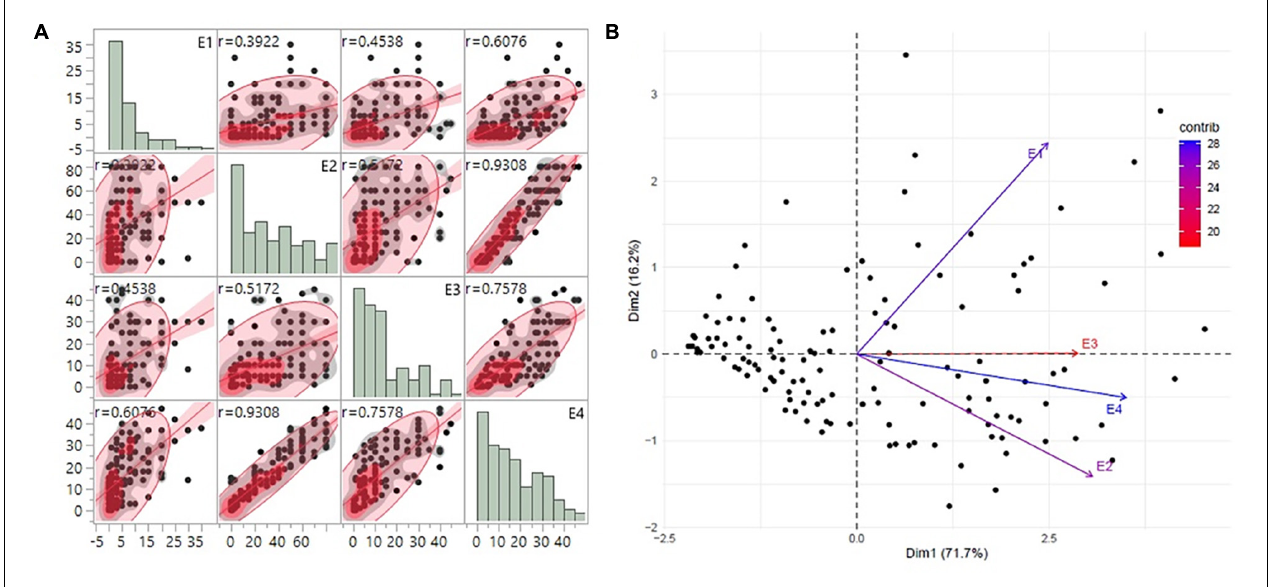
FIGURE 1 | (A) The trends of disease score distribution for 141 advanced breeding lines across the three individual environments E1, E2, and E3 along with the G × E data as E4. The histograms show the disease distribution across the environments, while the dot plots show the correlation of disease for respective lines across the environments. (B) PCA biplot of disease score across the four environments using the first and second principal component vectors. PCA, principal component analysis.